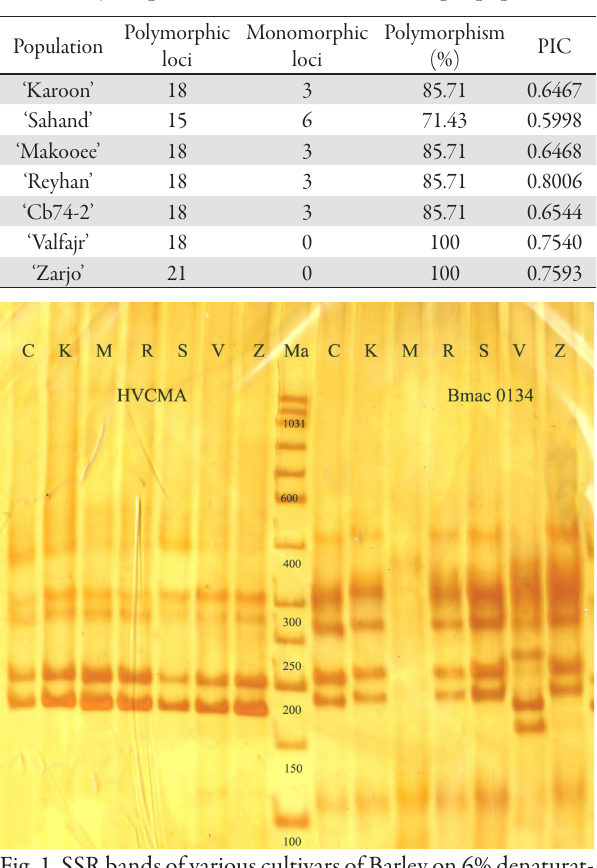
Tab. 2. Polymorphism values and mean of PIC per population